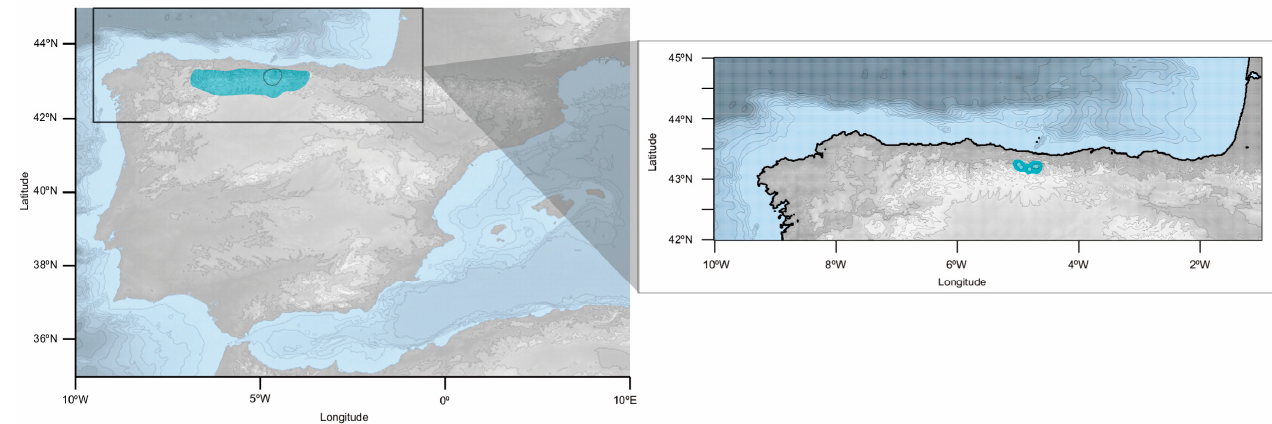
Figure 1. Bromus picoeuropeanus range in Picos de Europa, encircled in black, within the Cantabrian Mountains, highlighted in blue. In the box, the blue dots represent the localities of B. picoeuropeanus reported by Acedo and Llamas [29]. The base map was obtained using marmap R Pakage [47] and edited using Inkscape [48].